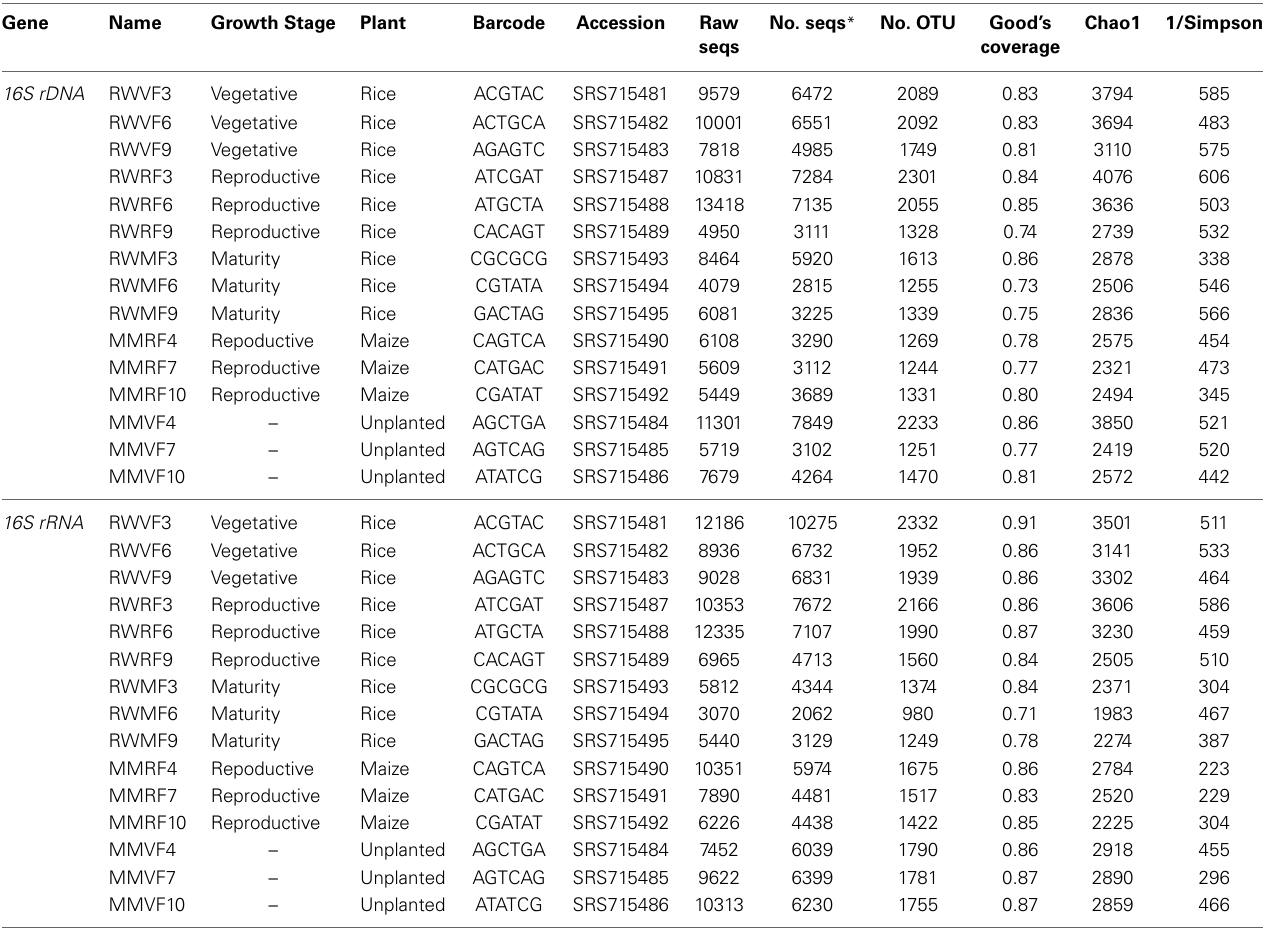
Table 2 | Number of bacterial sequences before and after quality management, barcode, number of OTUs, coverage, Chao1 and inverted Simpson index of the environmental samples analyzed by 454-pyrosquencing.